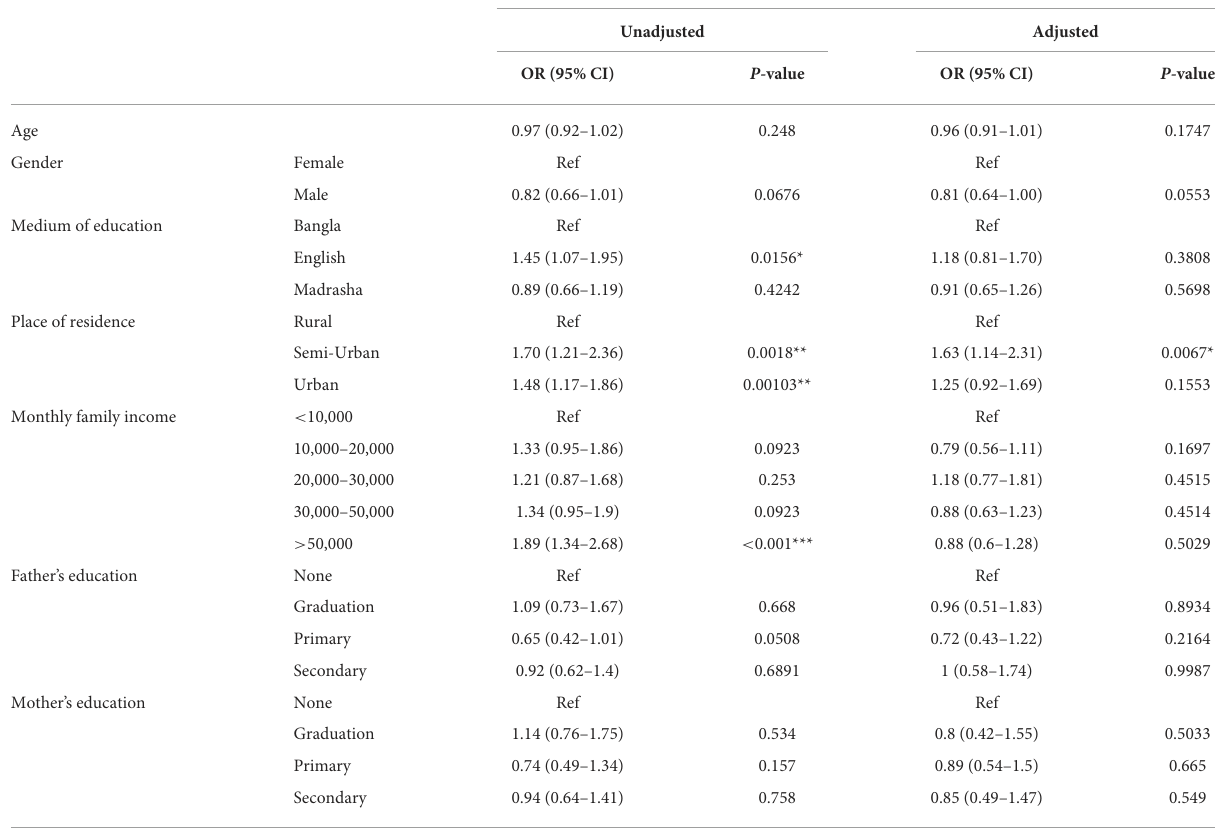
TABLE 6 Results of multiple logistic regression on factors determining level of diabetes